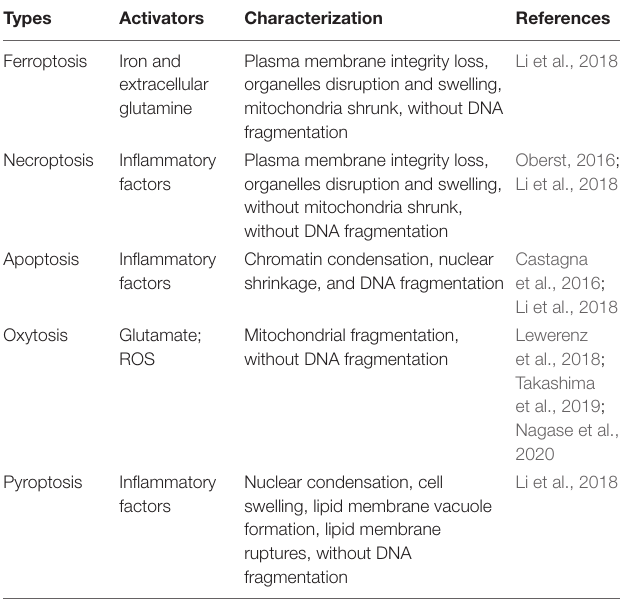
TABLE 1 | Neuronal death patterns of both ICH and